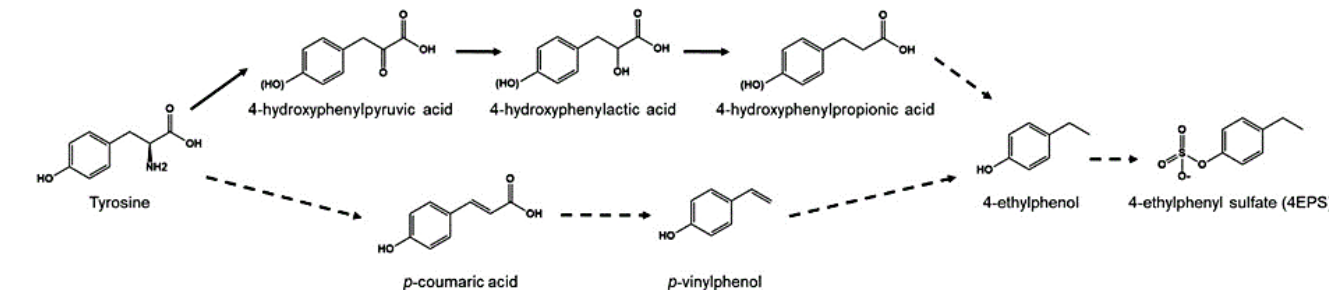
Figure 2. Microbiota gut–brain axis mechanisms focused on microbial metabolites and their influences on the brain. (Brain image from BioRender.com).